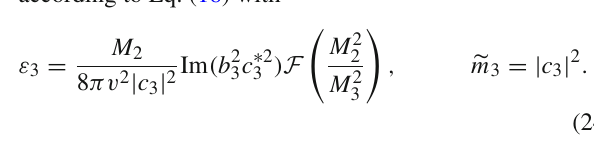
Fig. 2 First column: in the scenario of M D being the triangluar matrix, for the various trivial-value combinations of [ ρ,σ ] , the lower bounds of M 2 as functions of the lightest neutrino mass ( m 1 in the NO case, m 3 in the IO case), imposed by requiring the Scenario I leptogenesis